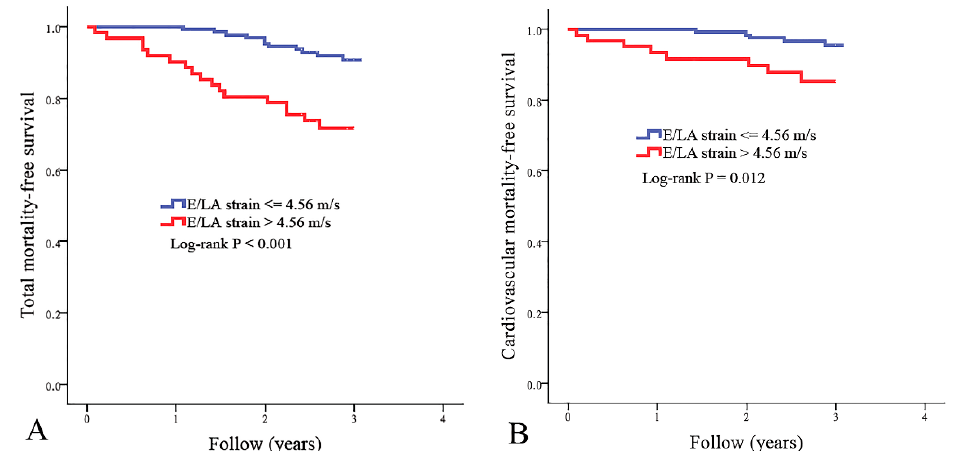
Figure 1. Kaplan–Meier curves for total mortality-free survival ( A , log-rank p < 0.001) and cardiovascular mortality-free survival ( B , log-rank p = 0.012) in all study patients subdivided according to the ratio of transmitral E wave velocity (E) to left atrial (LA) strain >4.56 m/s or not.